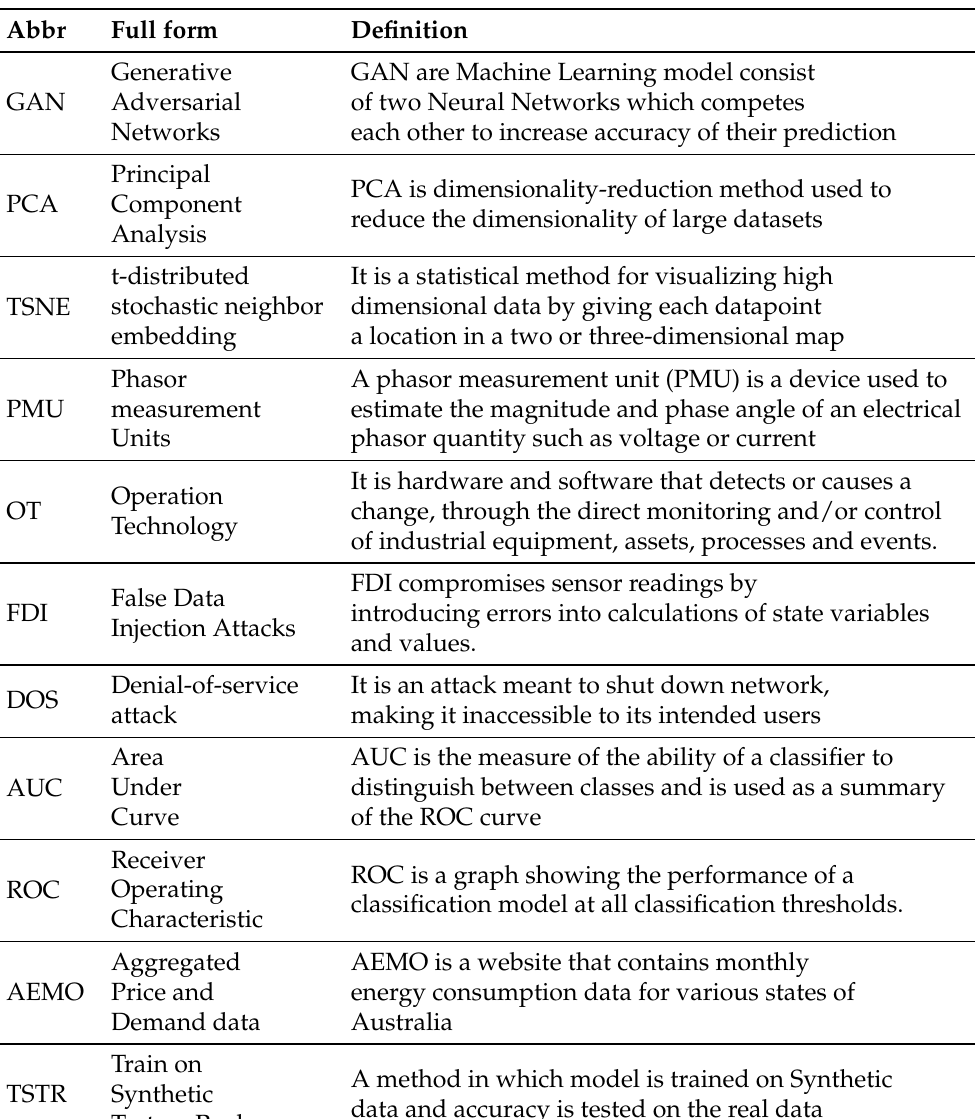
Table 1. List of